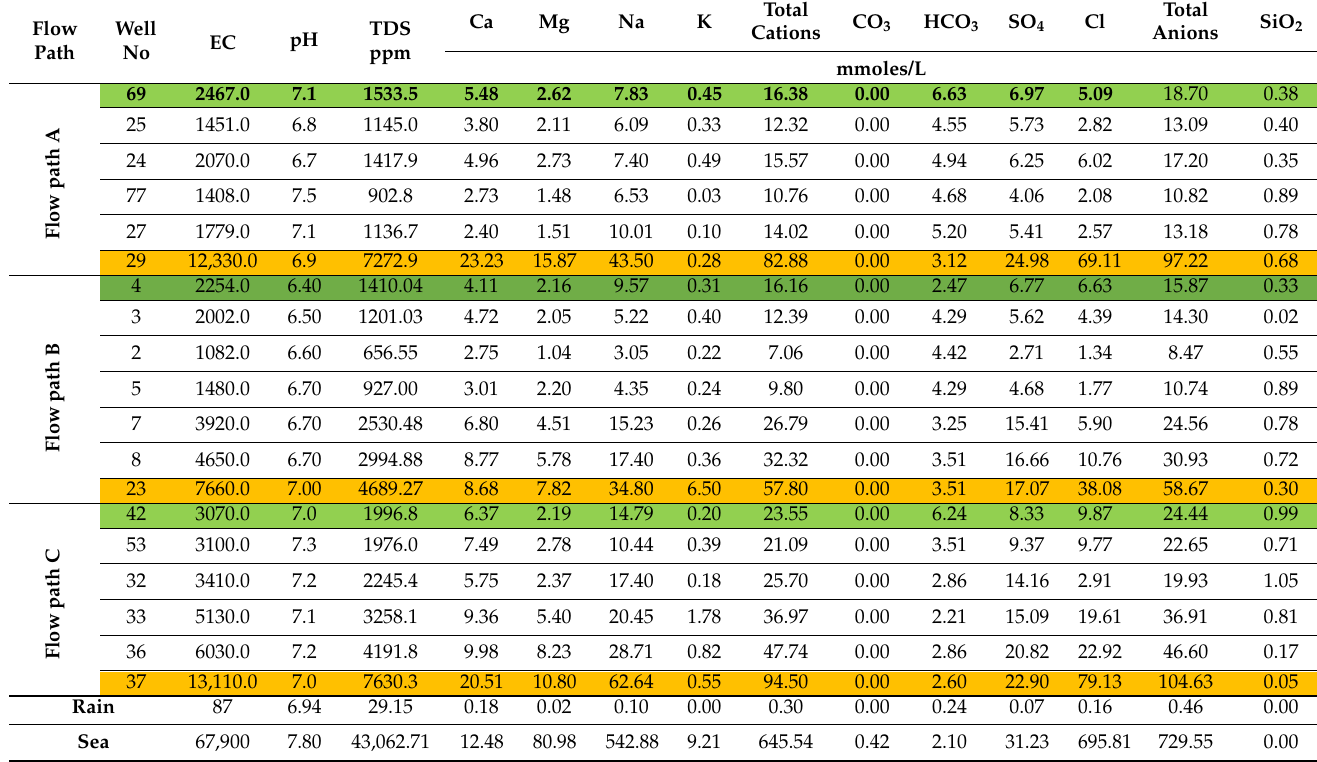
Table 3. Initial (green color) and final (orange color) chemical composition according to the flow path.